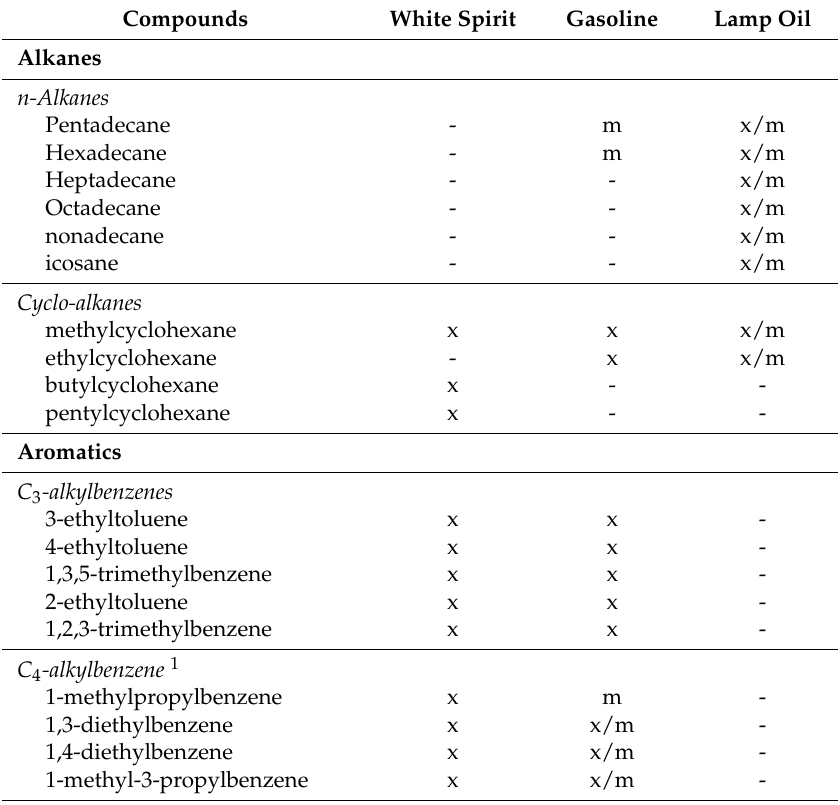
Table 6. Major compounds ‘x’ identified only in ILs and not encountered in the headspace of burnt substrates. Some components are identified as a minor constituent ‘m’ in the IL and sometimes it varies from sample-to-sample